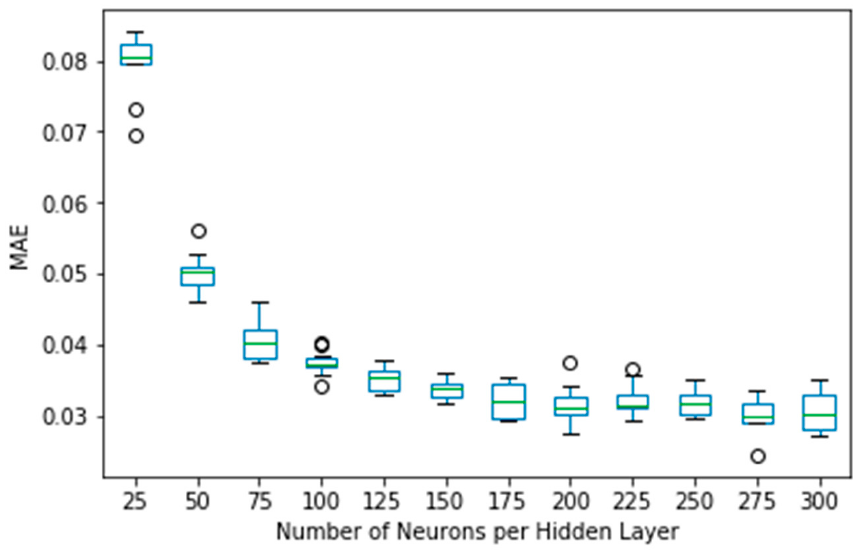
Figure 13. MAE vs. number of neurons per hidden layer.